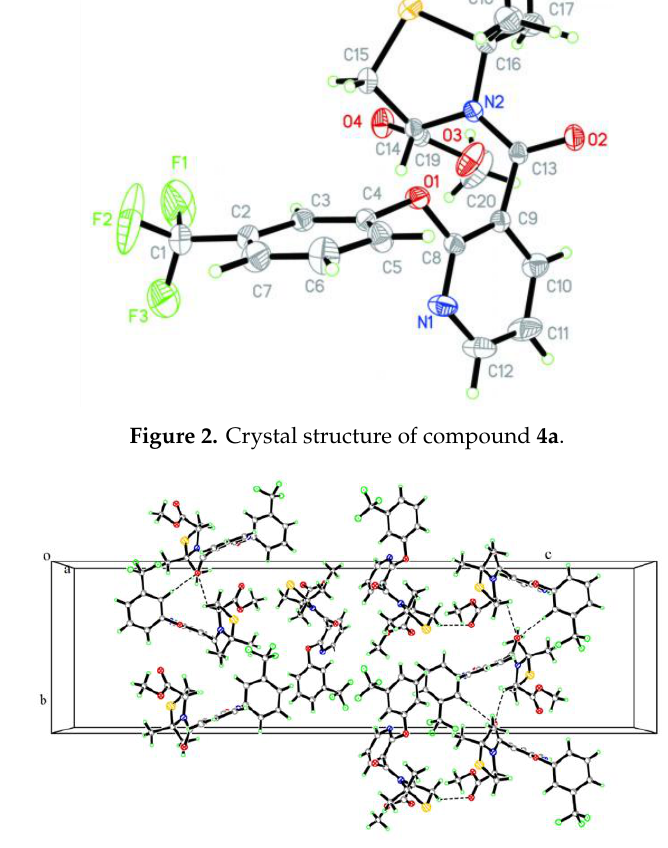
Figure 3. Packing view of compound 4a , hydrogen bonds are described dashed lines.